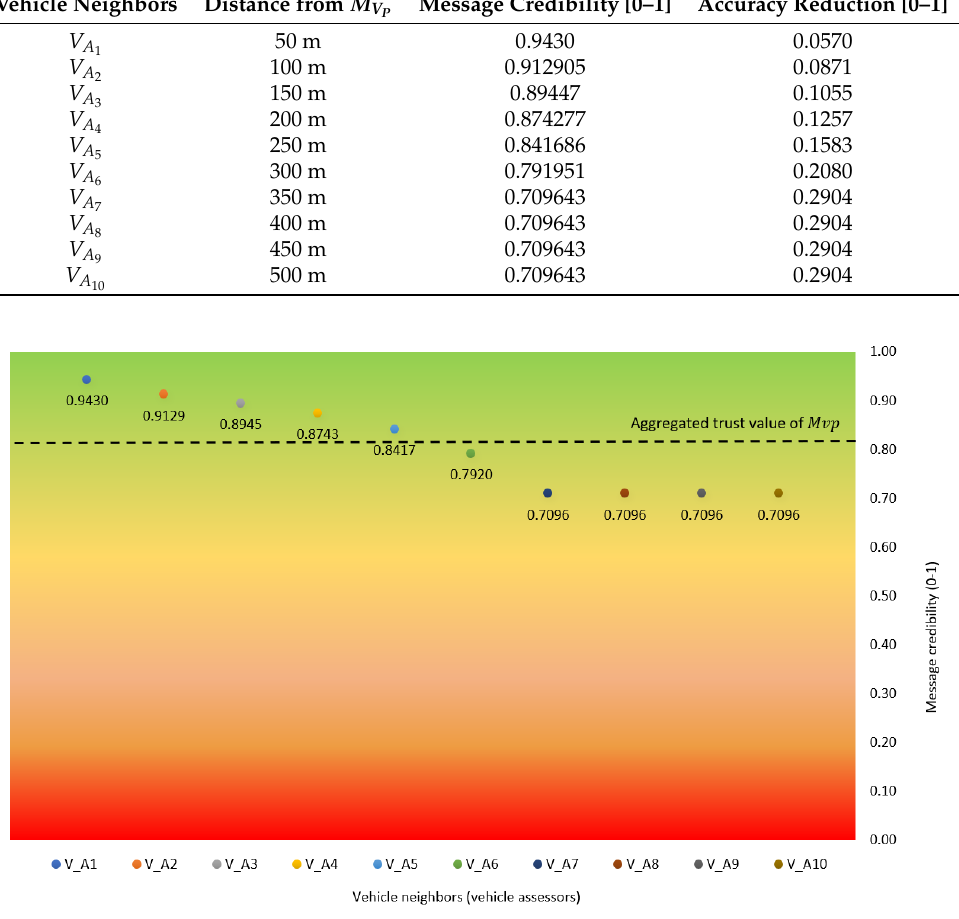
Figure 7. Trust value rating aggregation based on message credibility assessment by V An